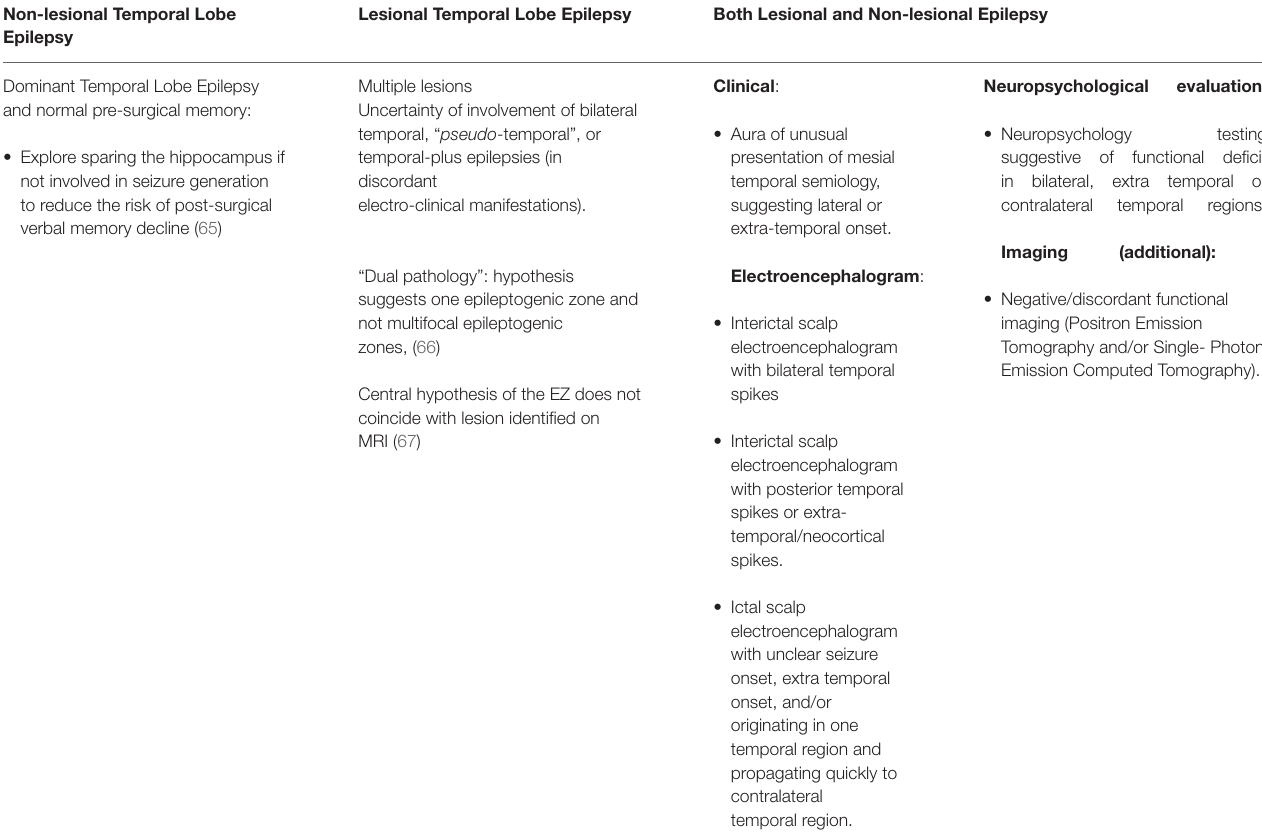
TABLE 2 | Indications of SEEG in lesional and non-lesional temporal lobe